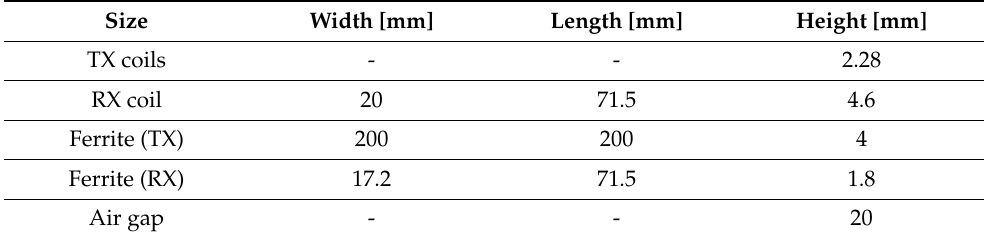
Figure 6. Simulation setup of the proposed models for WTT and WPT. ( a ) Perspective view of TX coils; ( b ) Perspective and side view of RX coil. The figure shows 3D modeling with a lumped model using Ansys Maxwell Electronics. Table 2. Size specification of the proposed WTT and WPT